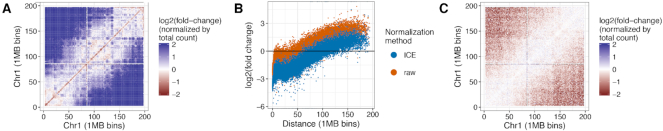
Genomic distance effect leads to artifactual differences in Hi-C contacts. (A) The figure plots the log fold-change in Hi-C contact counts between embryonic stem cell (ESC) and cortex Hi-C data (see Methods for details), plotted at 10 kb resolution on human chromosome 1. (B) Scatter plot of Hi-C log-fold change as a function of genomic distance, where each point corresponds to a pair of 10 kb loci. The two point colors correspond to raw counts (red) and counts normalized using ICE (blue). (C) Similar to panel A, but for two replicate Hi-C experiments performed in mouse cortex.